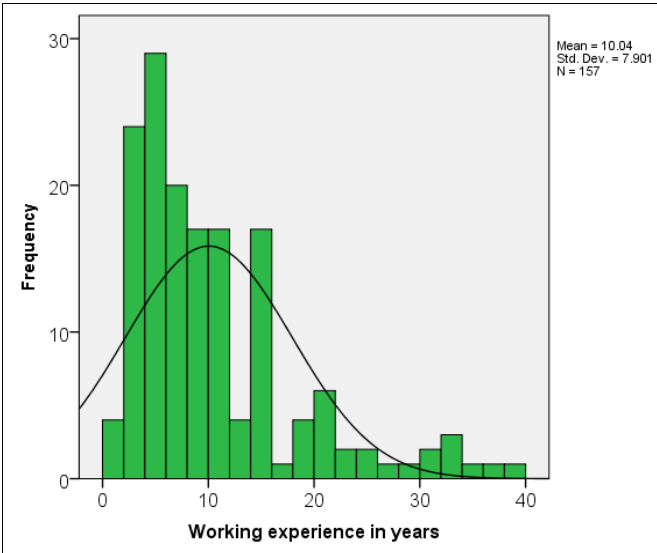
Figure 6: The Mean and Standard Deviation of the Respondents’ Experience.